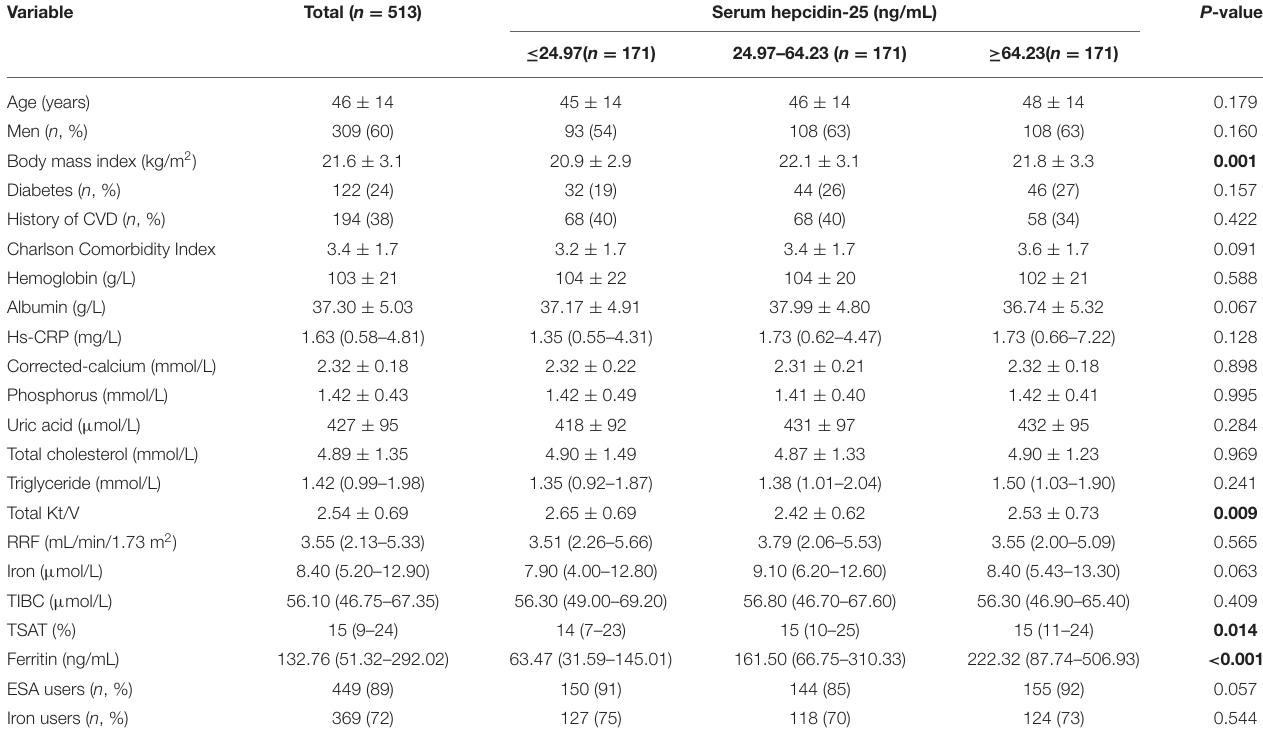
TABLE 1 | Baseline characteristics of individuals stratified by tertiles of baseline serum hepcidin-25 levels.